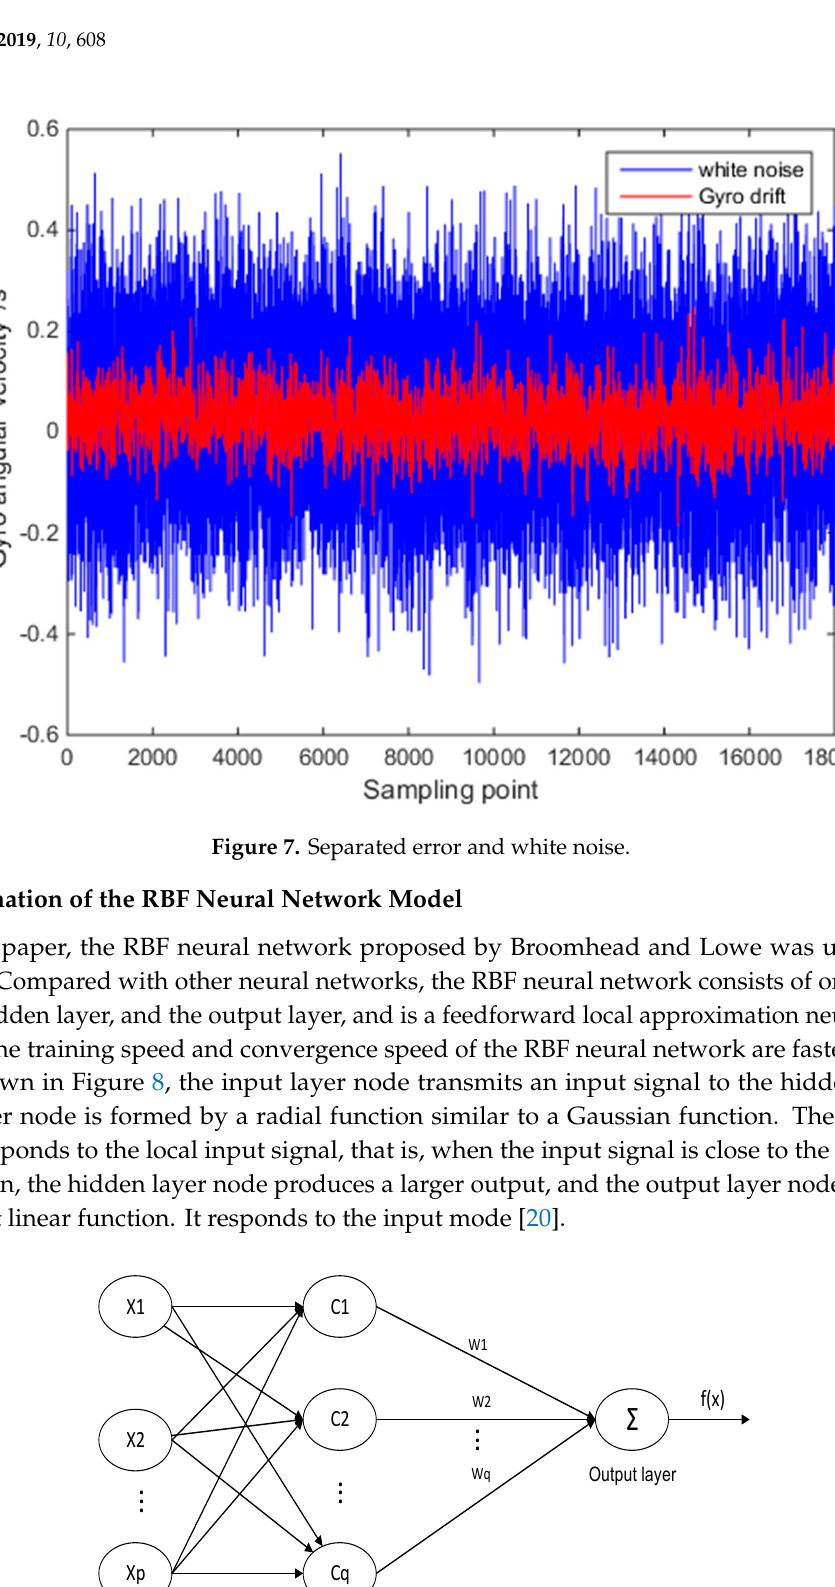
Figure 8. Radial basis function (RBF) neural network structure.